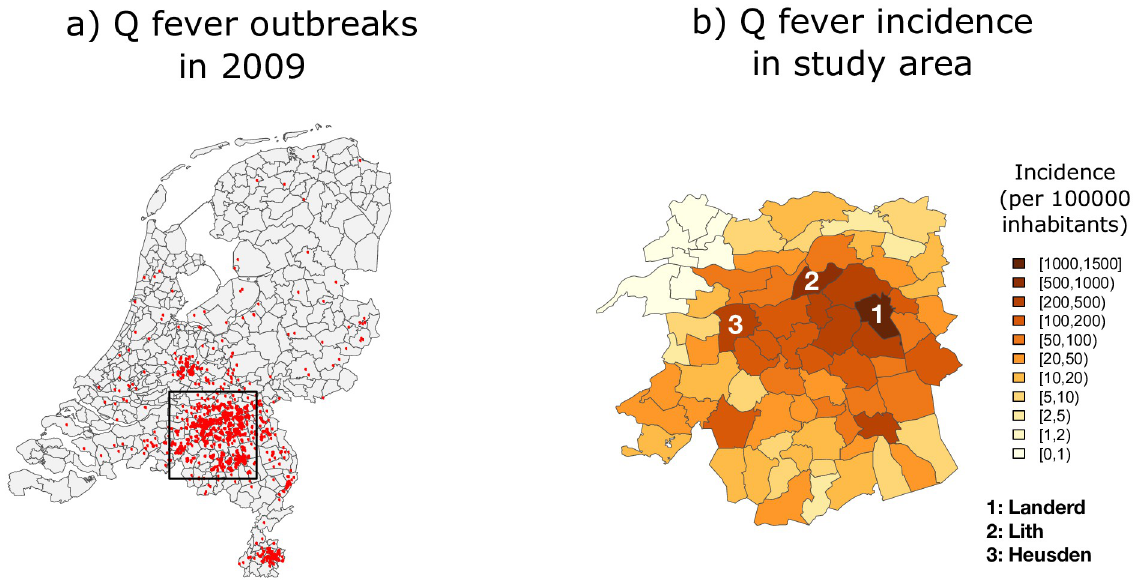
Fig 2. Map of human Q fever cases in the Netherlands, 2009. Left: red points indicate the residential addresses of human cases (2309 in total). Right: study area in the south of the Netherlands showing (raw) incidence (per 100000 inhabitants) of Q fever by municipality in 2009. Source: geo-referenced data are obtained from https://www.cbs.nl/en-gb/onze-diensten/open-data/statline-as-open-data/cartography. a) Q fever outbreaks in 2009. b) Q fever incidence in study area.